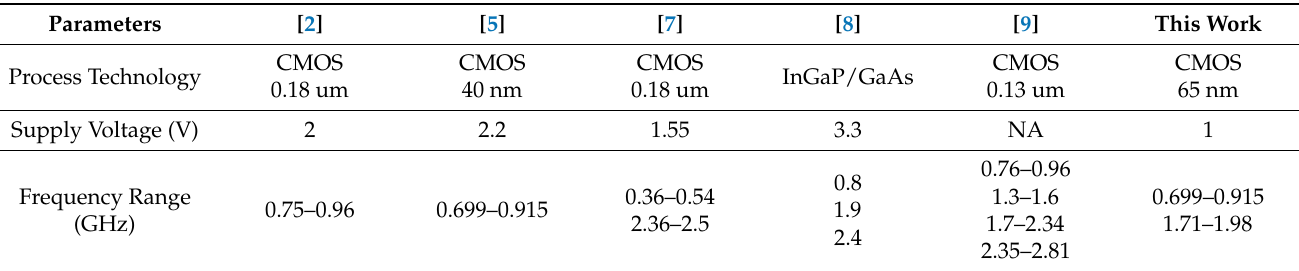
Table 1. Comparison table over various TIA